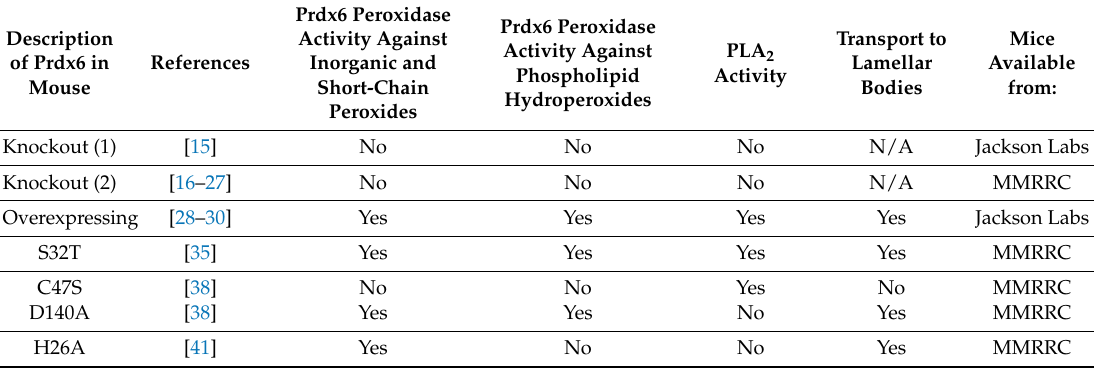
Table 1. Summary of the description of mice discussed in this review. PLA 2 : Phospholipase A 2 ; MMRRC: Mutant Mouse Resource and Research